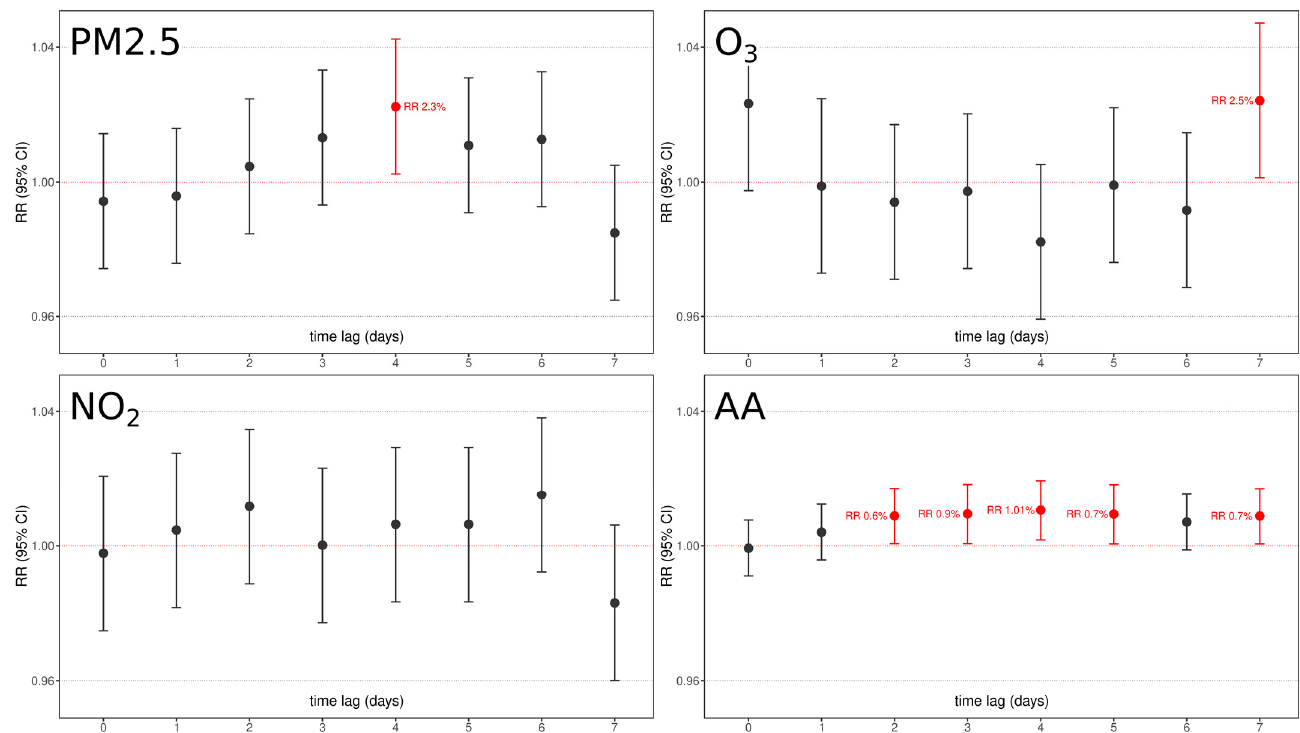
Figure 5. Graphical representation of chemical pollutants under analysis (PM2.5, NO 2 , O 3 ) and aeroallergen (AA) concentrations relative risk and confidence interval association with PTB as per 7-days time lags. Red boxes underline significant factors with their relative lag RR. All models were adjusted for day of the week, holidays, summer population decrease, and yearly medium/long-term trend function.